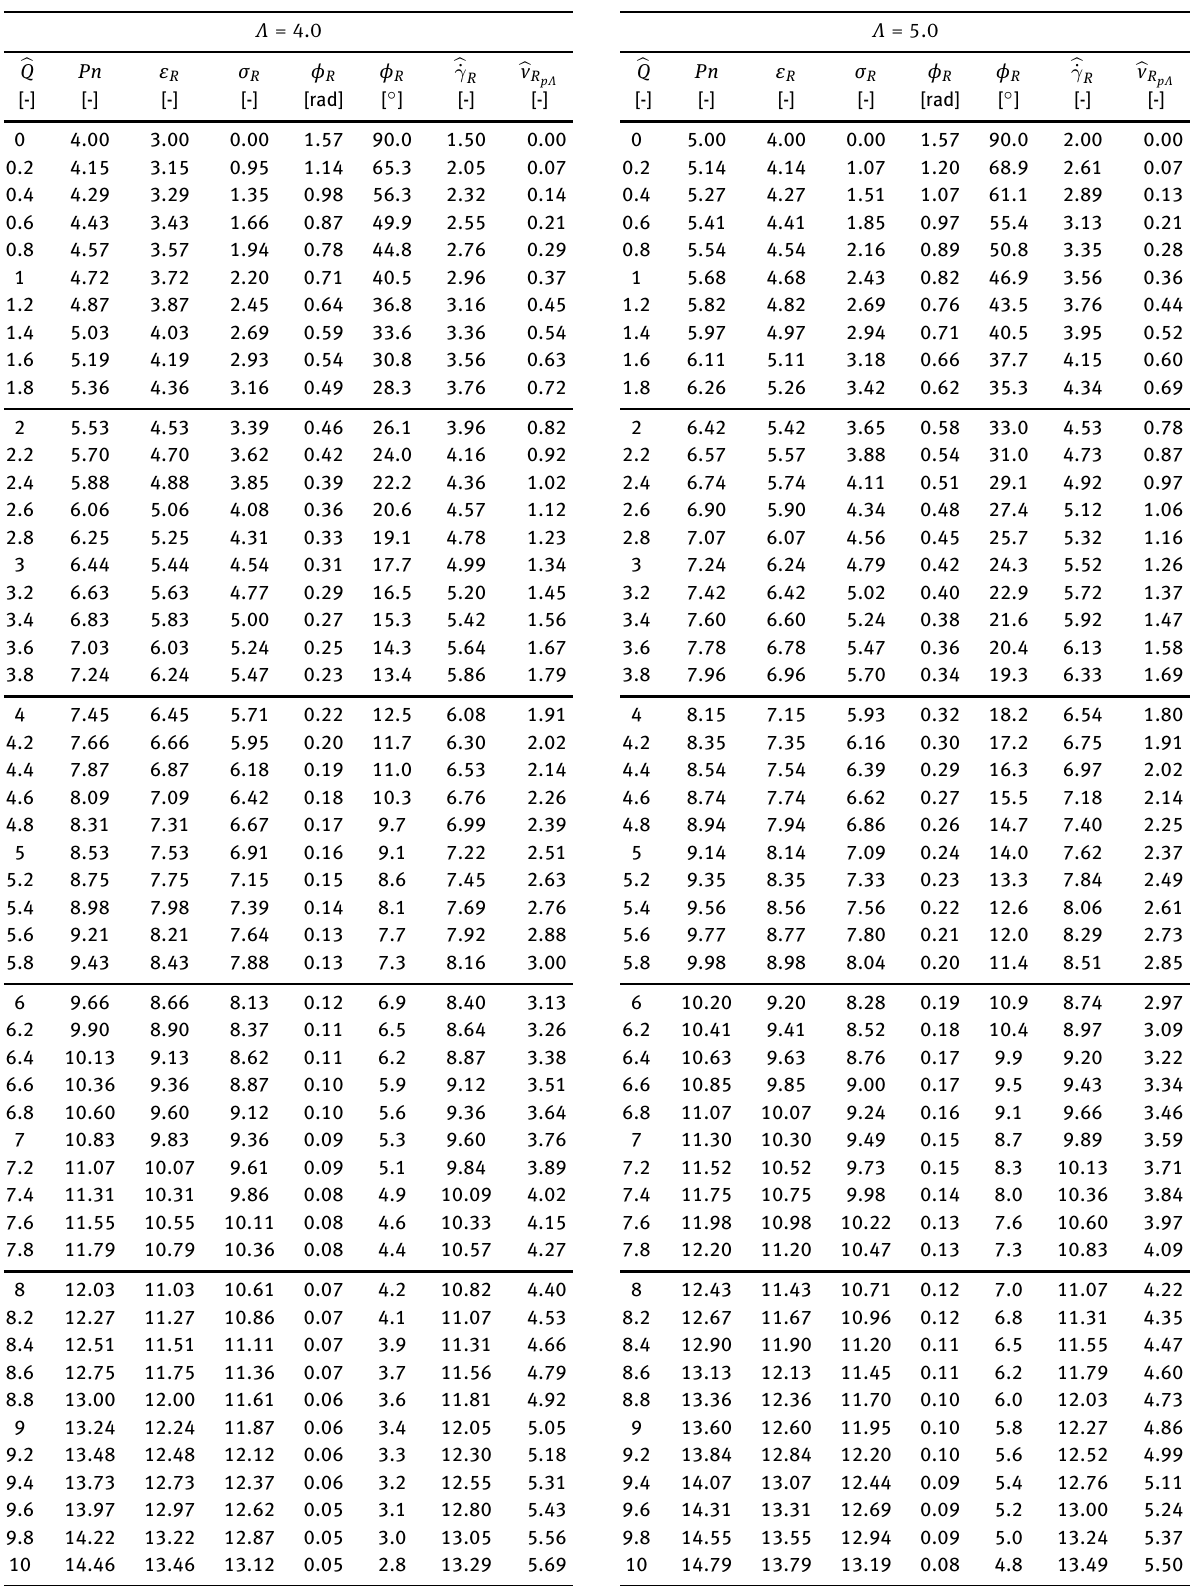
Table E6: Brief summary of numerical values of the discharge rela- tions shown in Figure 7 for a thixotropy factor Λ = 4.0 .